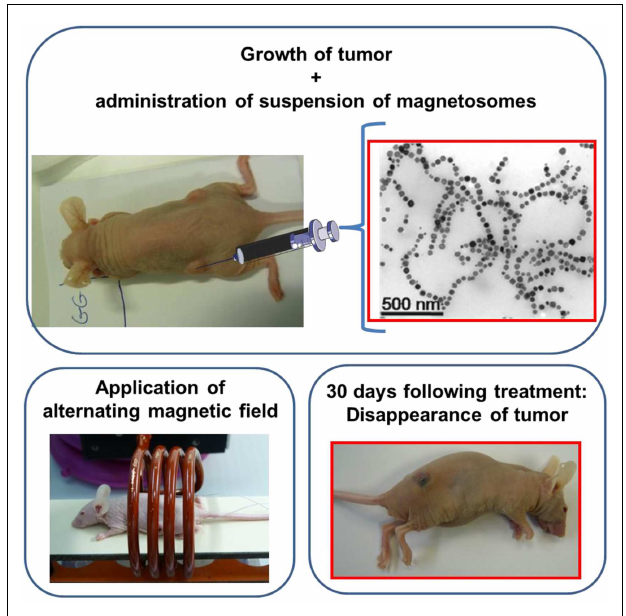
FIGURE 2 | Schematic diagram showing the treatment of a mouse using magnetic hyperthermia .The mouse has a breast tumor xeno-grafted under its skin. A suspension of magnetosomes is administered at the center of the tumor; the mouse is then positioned inside a coil where an alternating magnetic field is applied three times during 20min.The tumor disappears 30days following the treatment as can be seen in the bottom right